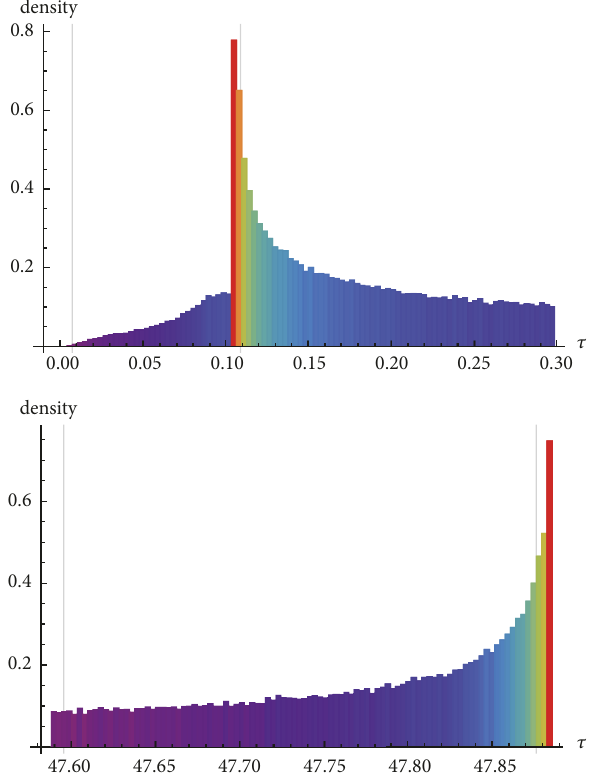
Figure 7: Close views of the plot at the bottom of Figure 5, corresponding to the barrier width 𝑏 − 𝑎 = 4 . Top : small tunneling times and bin length ≈ 0.0031𝑎.𝑢. ( ≈ 0.15 attoseconds). The vertical grey linein the left of this plot corresponds tothe time the lighttakes to travel the barrier distance. The percentile 1 % (corresponding to ≈ 5.1 𝑎.𝑢. ≈ 247 attoseconds) is out of the range of this plot. Bottom: large tunneling times, with bin length ≈ 2 𝑎.𝑢 ≈ 100 attoseconds. The vertical grey line corresponds to the percentile 99